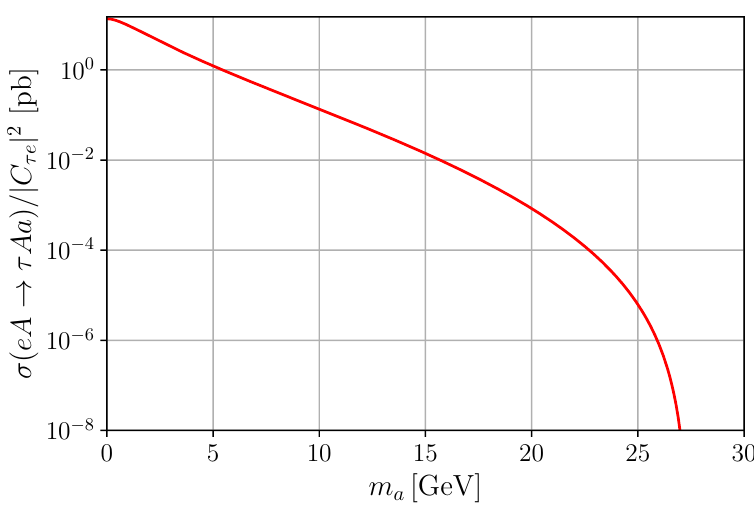
Figure 2 . The cross section for the process eA Z → τA Z a as a function of m a , assuming an ALP UV scale Λ = 1 TeV and assuming a Woods-Saxon nuclear form factor, given in eq.